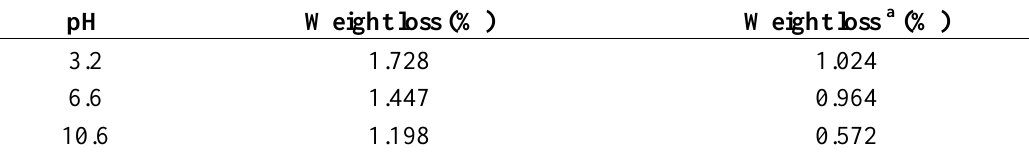
Table 1. Weight losses of powders before and after acid-etching